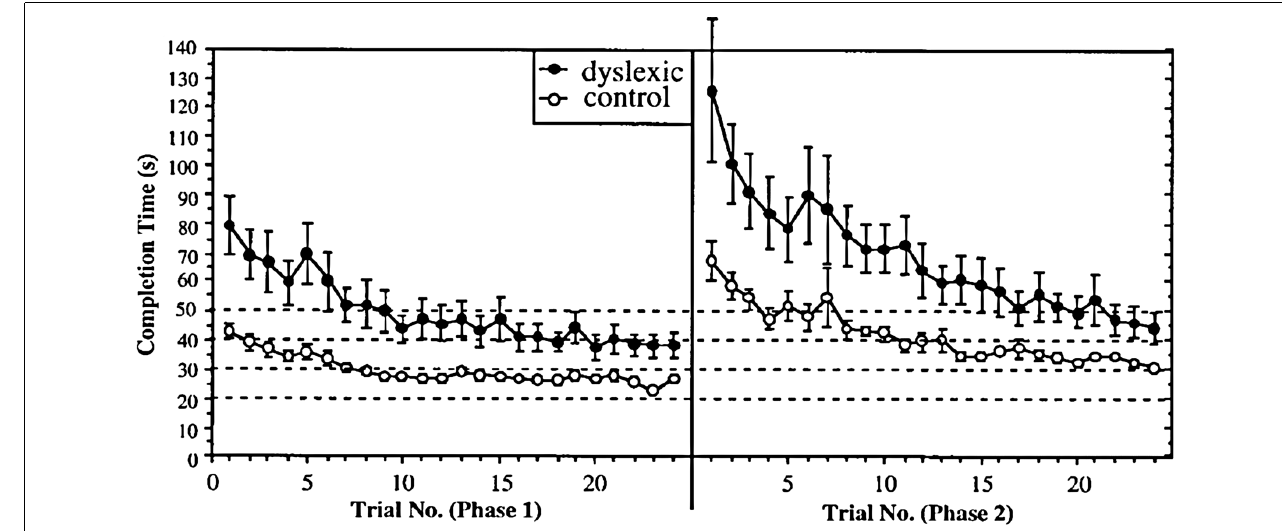
FIGURE 3 | Speed of circuit completion with practice.